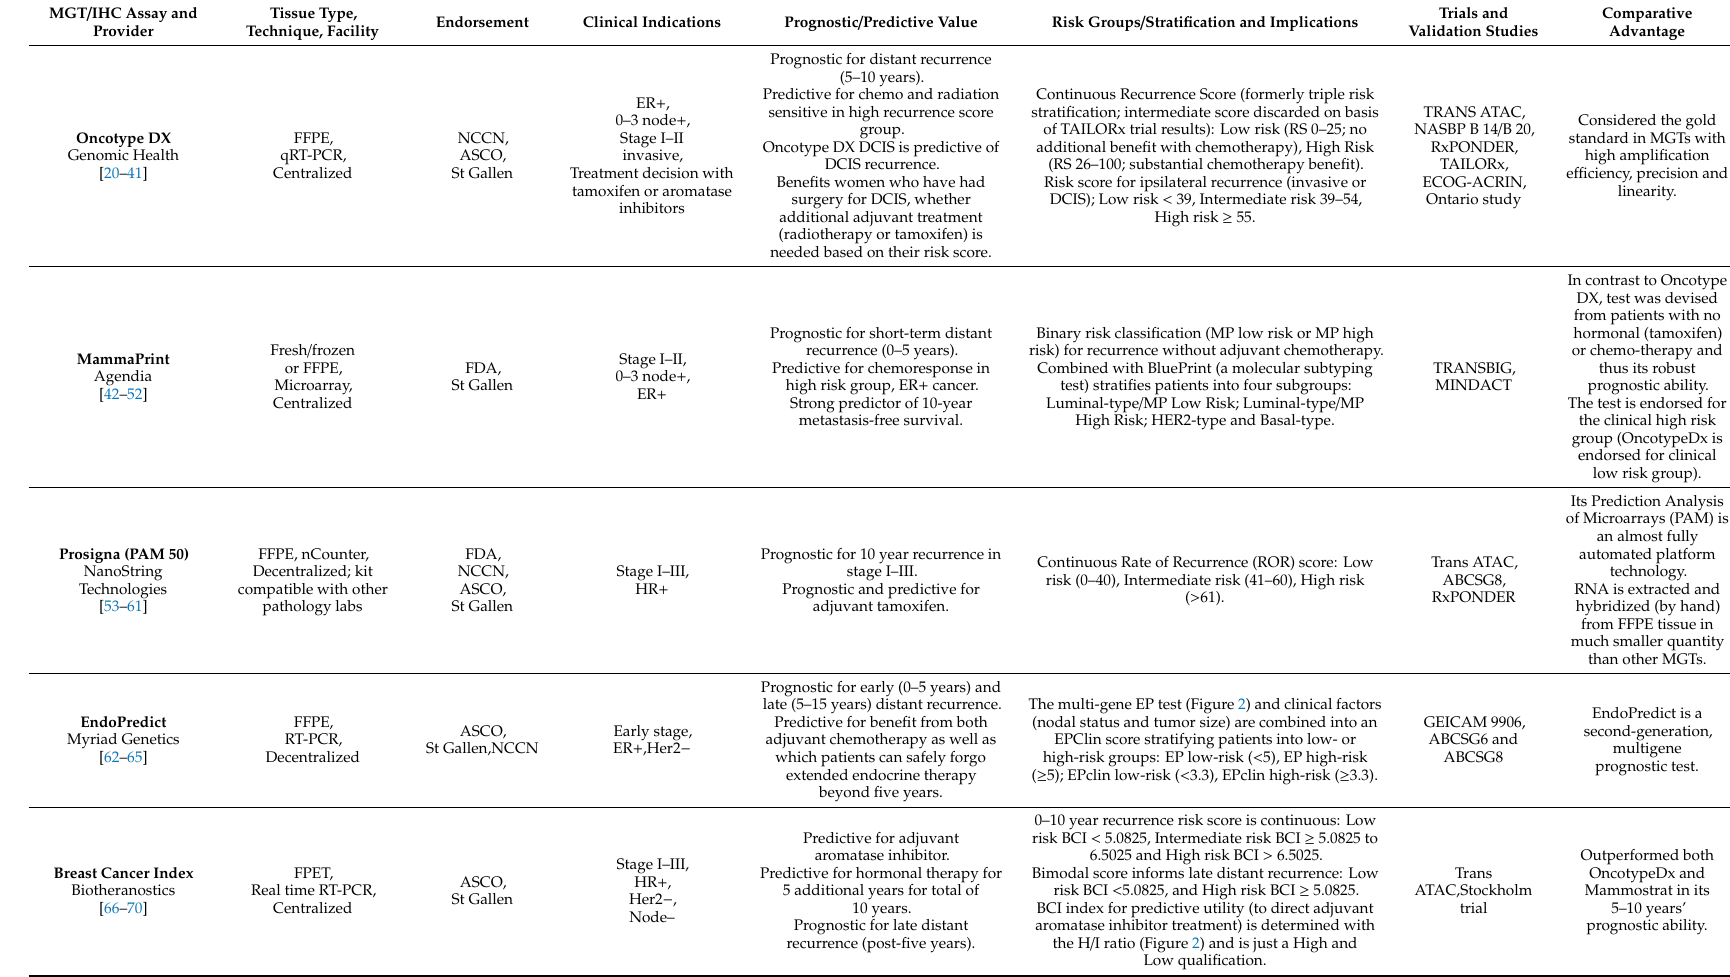
Table 1. Prognostic / predictive multigene tests routinely used in the clinical settings for breast cancer. FFPE / FPET [Formalin-fixed Para ffi n-embedded]. MGT / IHC Assay and